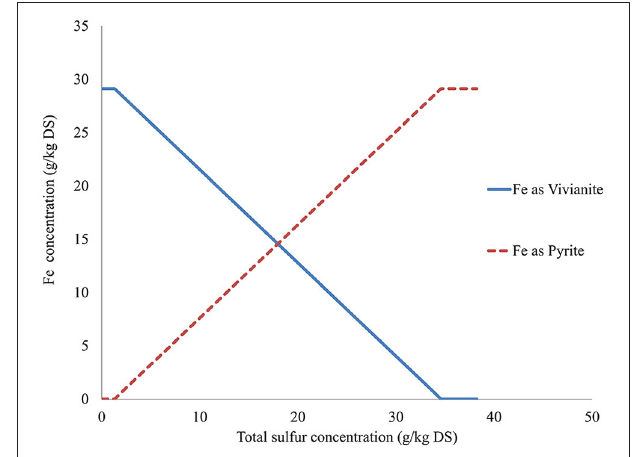
FIGURE 6 | Predicted iron fractionation in function of total sulfur concentration (average of the predicted results obtained from all anaerobically digested sludge under